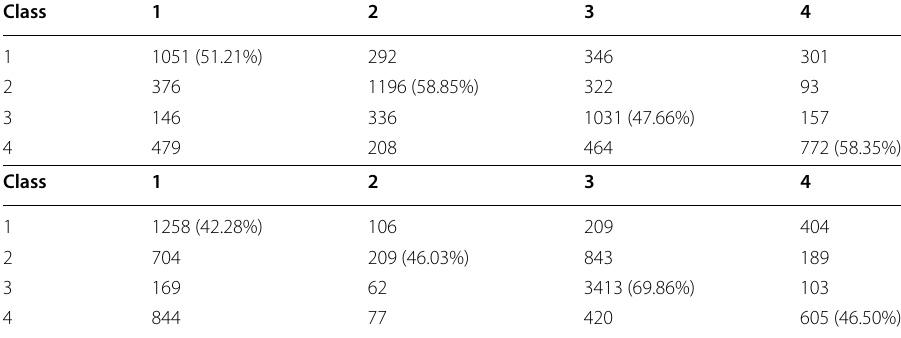
Table 1 Confusion matrices of participants 5 and 6 using SVM